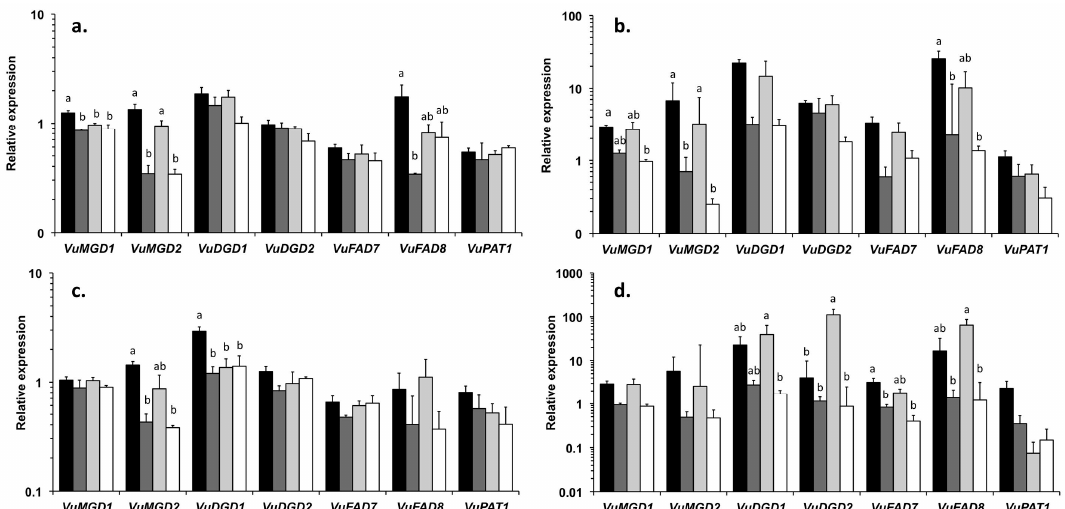
Figure 3. Relative expression of genes involved in lipid metabolism in leaves of ( a , b ) EPACE-1 and ( c , d ) IT83-D plants exposed to the following treatments: Control (C, black bars), Drought (D, dark grey bars), Ozone (O, light grey bars), Ozone + Drought (OD, white bars). Measurements were performed 7 and 14 days after the onset of the stress treatments. Means ± SEM are shown ( n = 3). Each value is the average of two technical replicates. Expression of target genes was normalized to the expression of the reference gene VuEF-1 α . When significant differences were found, letters indicate homogenous subsets at each time point for a given cultivar (one-way ANOVA and Tukey post-hoc tests, α = 0.05). VuMGD1 , type 1 monogalactosyl-diacylglycerol synthase; VuMGD2 , type 2 monogalactosyl-diacylglycerol synthase; VuDGD1 , type 1 digalactosyl-diacylglycerol synthase; VuDGD2 , type 2 digalactosyl-diacylglycerol synthase; VuFAD7 , ω -3 fatty acid desaturase 7; VuFAD8 , ω -3 fatty acid desaturase 8; VuPAT1 , patatin-like lipid acyl hydrolase; VuEF-1 α , elongation factor 1 alpha.